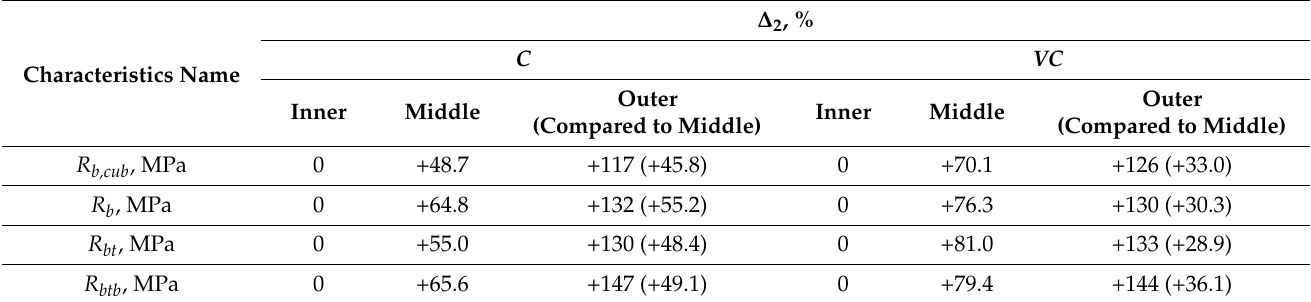
Table 7. Difference in values ( ∆ 2 ) of differential characteristics between centrifuged and vibrocen- trifuged